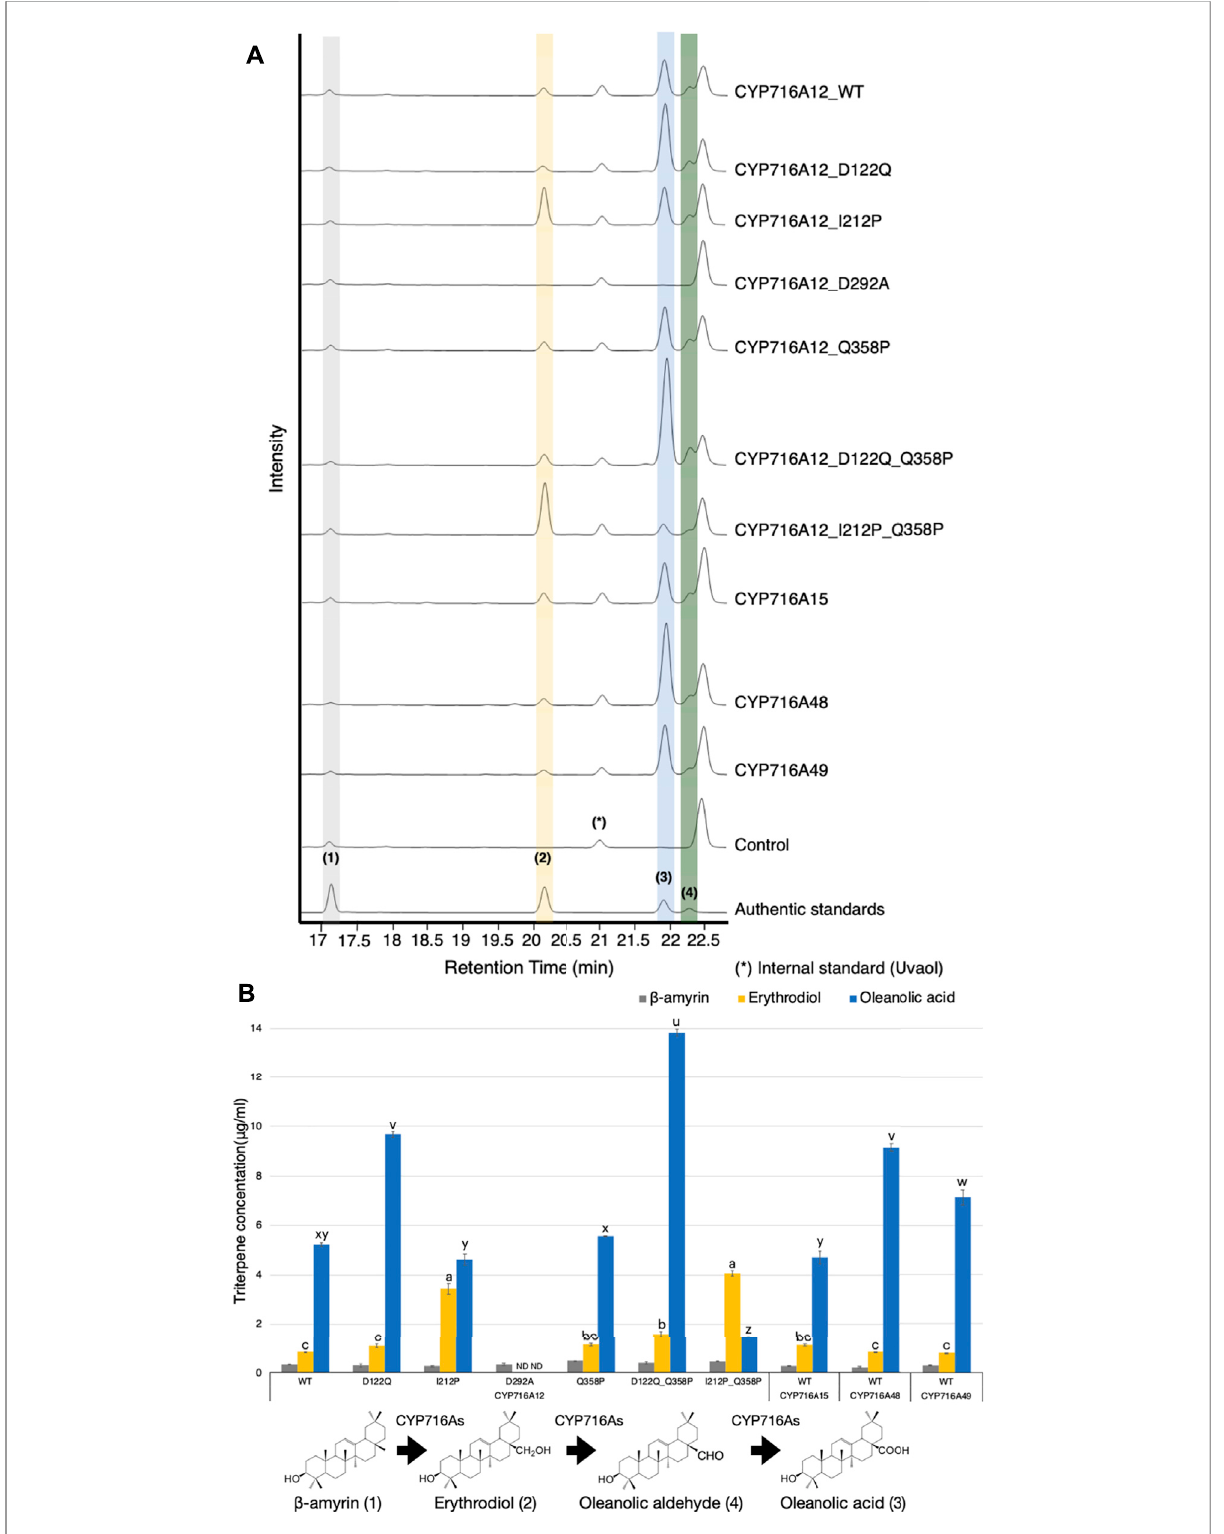
FIGURE 4 In vivo activities of selected CYP716As and CYP716A12 and its variants against triterpene skeletons. (A) Total ion chromatograms (TICs) of extracts from yeast harboring one bAS expression vector for producing β -amyrin and three CYPs expression vectors